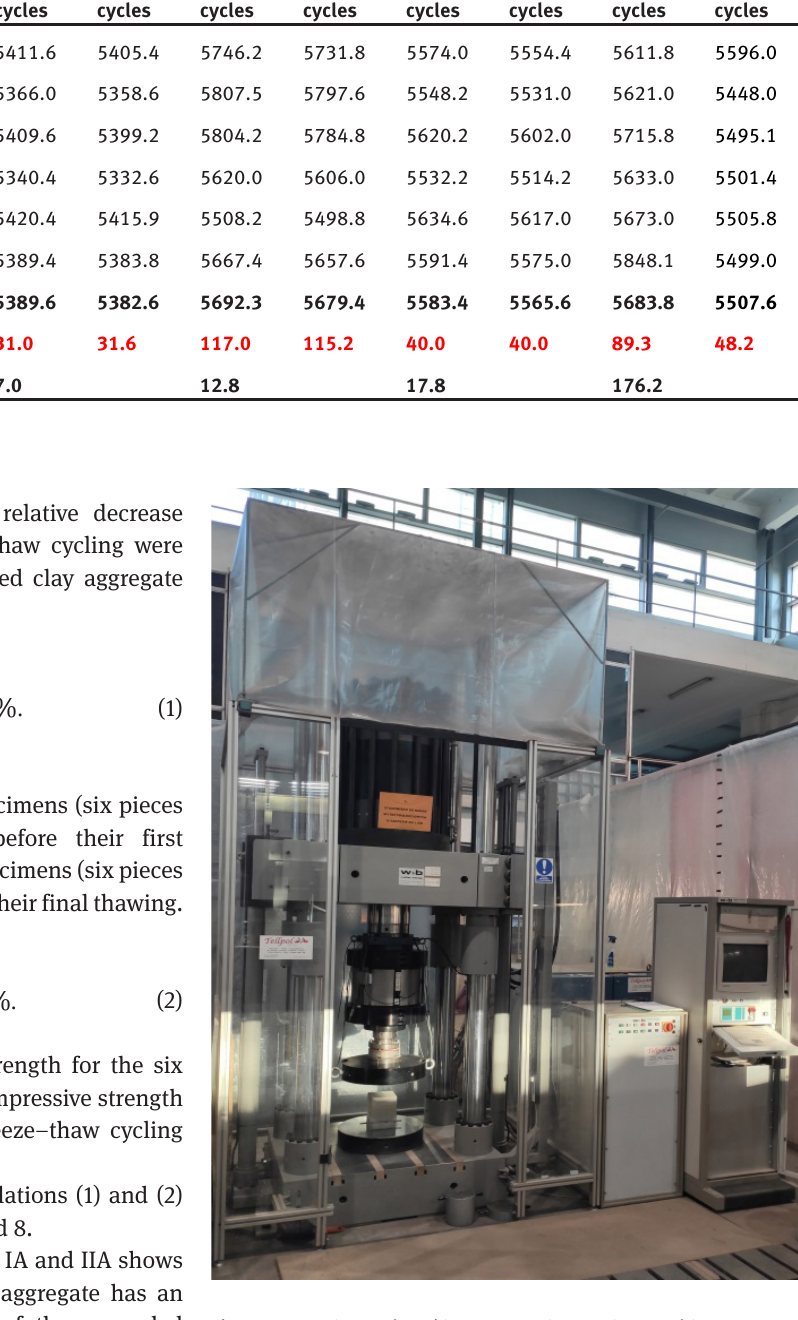
Figure 3: Specimen placed in compression testing